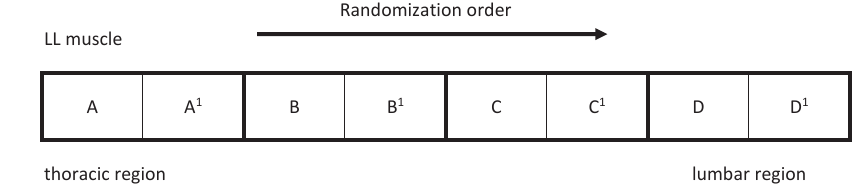
Fig. 1. Division of musculus longissimus lumborum into samples intended for refrigerated and frozen